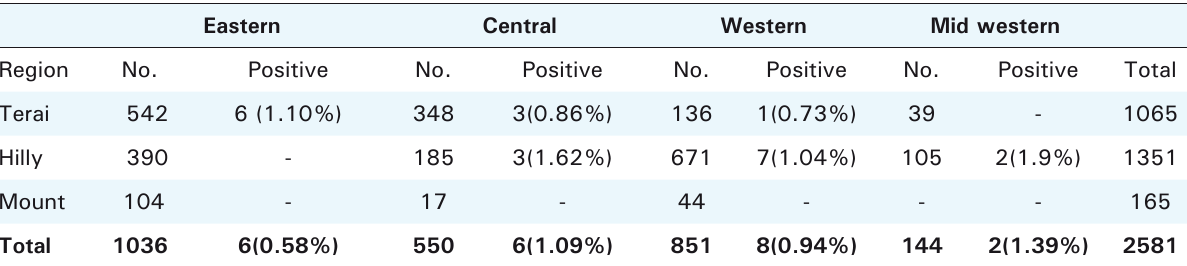
table 4. Prevalence of Syphilis in different regions of various development